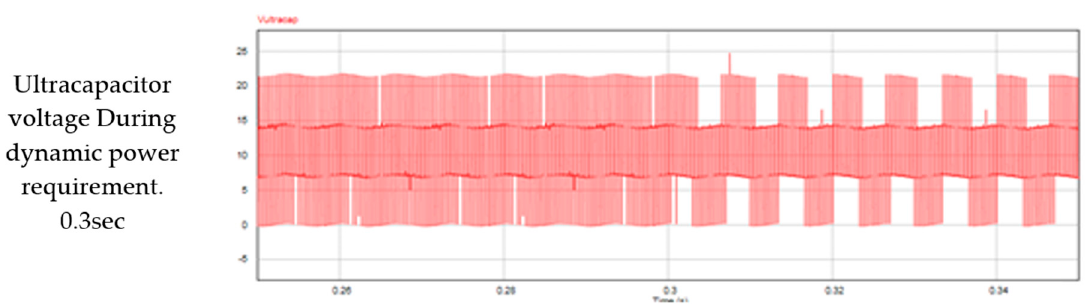
Figure 18. Ultracapacitor terminal voltage.